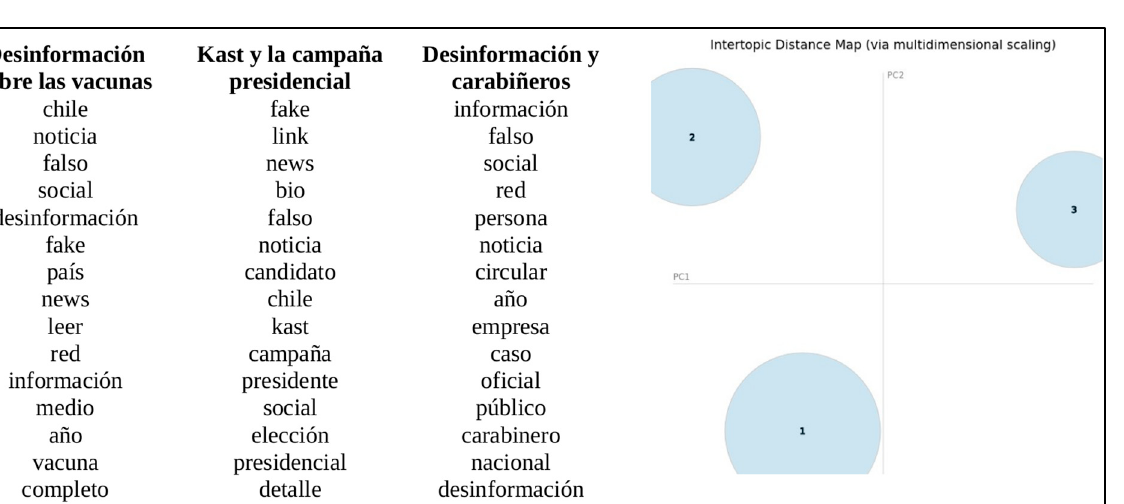
Figure 5. Top words and projection in the main foreground of the three topics obtained with LDA.